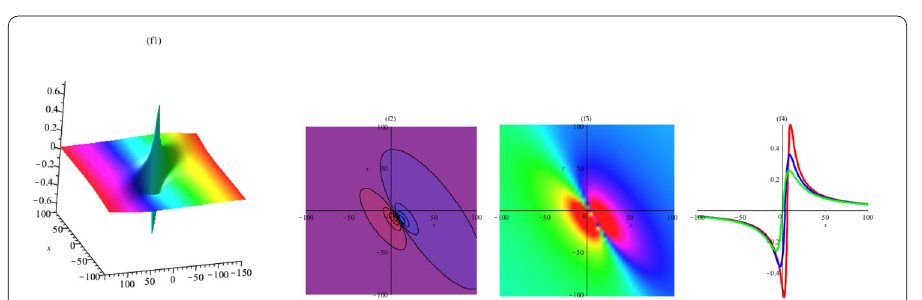
Figure 3 The plot of rogue wave (3.5) with fractional order α =